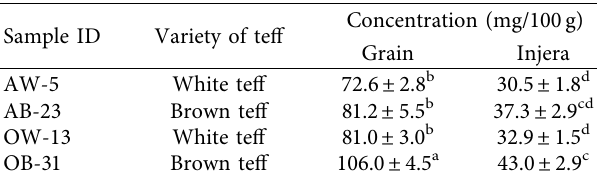
Table 2: Comparison of the ascorbic acid content (mean ± SD) in the selected white and brown tef [ Eragrostis tef (Zuccagni) Trot- ter)] grains and injera